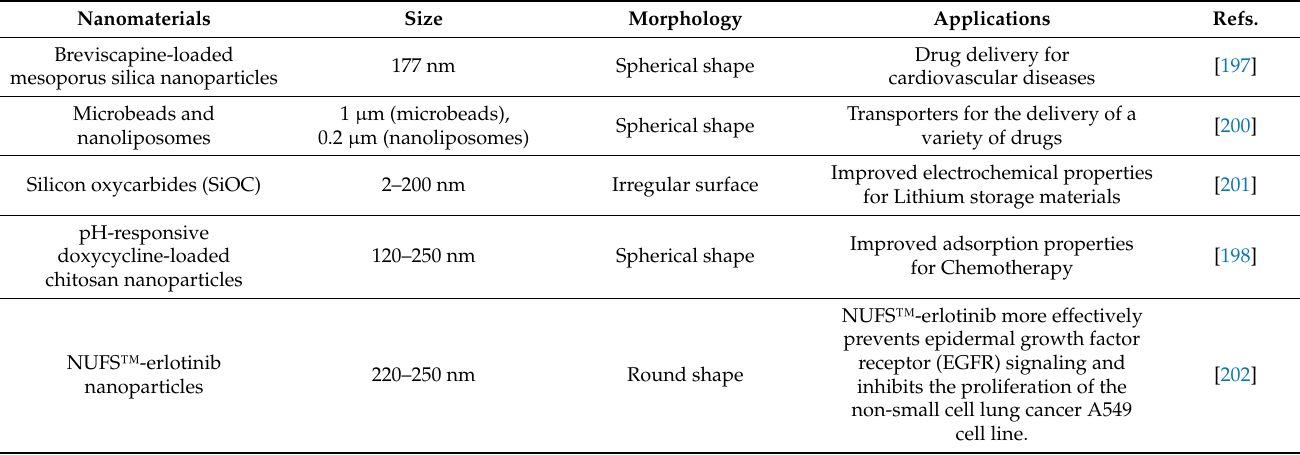
Figure 9. Supercritical fluid technology for producing nanoparticles in which the drug and the polymer (cellulose nanofibers) are processed together to improve the nanoparticle stability and disaggregation. Image created with BioRender. Table 5. Different nanomaterial types synthesized using the supercritical fluid and chemical reaction methods for advanced